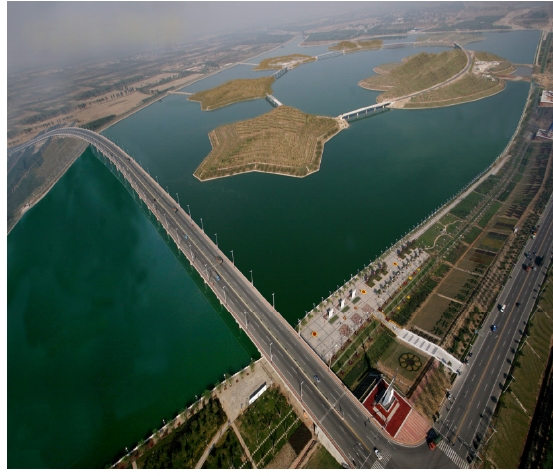
Figure 11. Water storage projects in the Huangtai lake district.